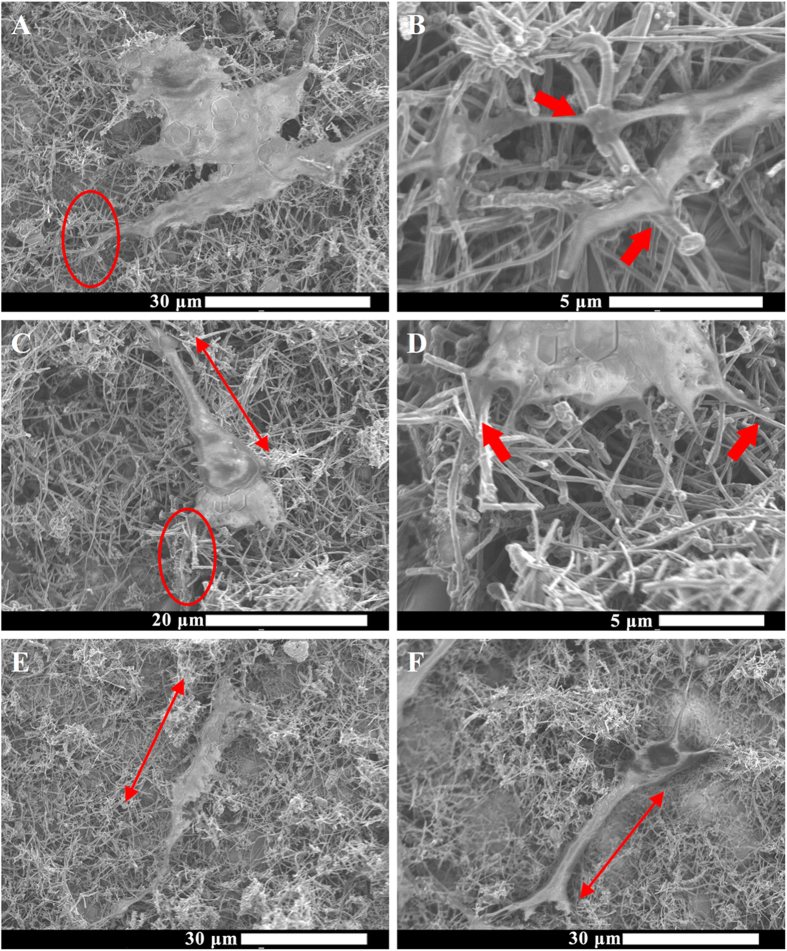
Representative SEM images of adipose derived stem cells grown on MWCNT substrates. Red circles in (A) and (C) are magnified in (B) and (D) respectively with red arrows showing cell adhesion by wrapping around nanotubes (B) or cell protrusions going underneath nanotube structures (D).